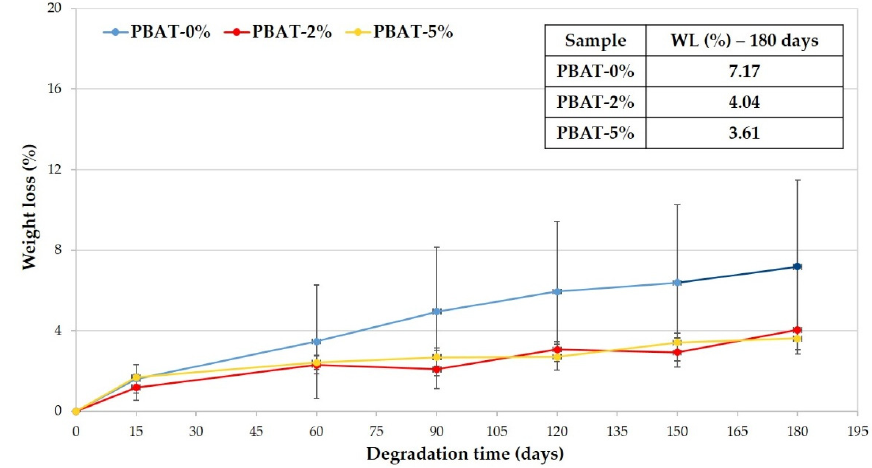
Figure 2. Weight loss percentage vs. degradation time of PBAT polymer samples.